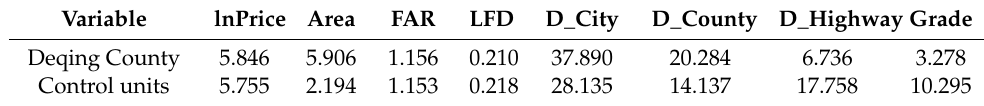
Table 2. Comparison between Deqing County and Counties without COCLEM.